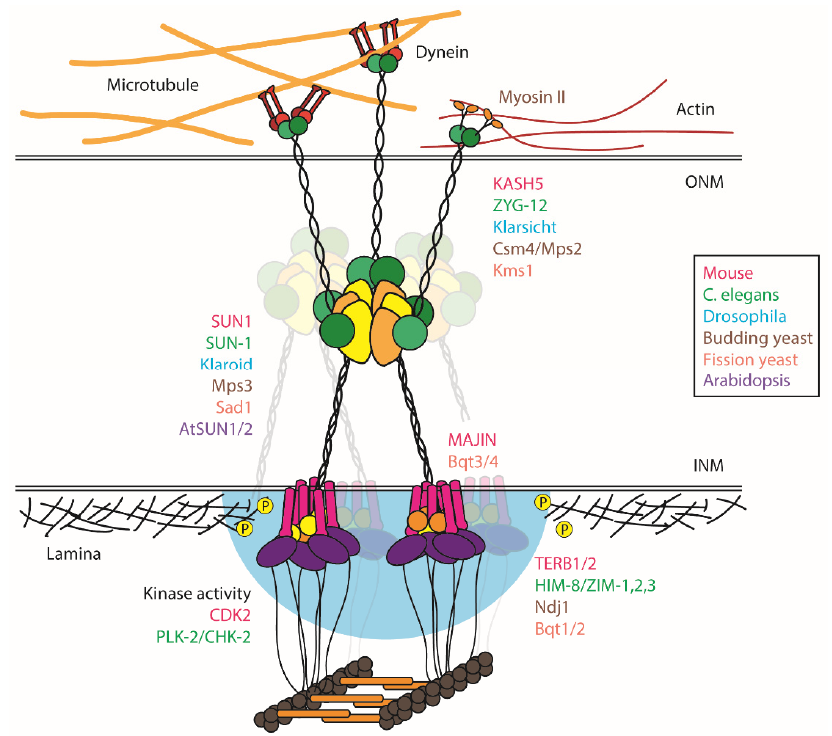
Figure 1. Schematic representation of meiotic chromosome–NE–cytoskeletal complexes in diverse species. The SUN domain forms a trimer, and an adjacent extended α -helical domain forms trimeric coiled-coils, while KASH domain proteins dimerize. SUN domain trimers can dimerize and are proposed to interact with KASH domains from different dimers to create branched complexes, which may contribute to the clustering of chromosome attachment sites during meiosis. The nucleoplasmic domain of SUN proteins interact with chromosomal proteins, which often depends on the expression of meiosis-specific adapter proteins. Small proteins that span the inner nuclear membrane, includ- ing MAJIN in most metazoans and Bqt3/4 in fission yeast, are also essential for the coupling of chromosomes to the LINC complex and/or clustering of LINC complexes (translucent structures